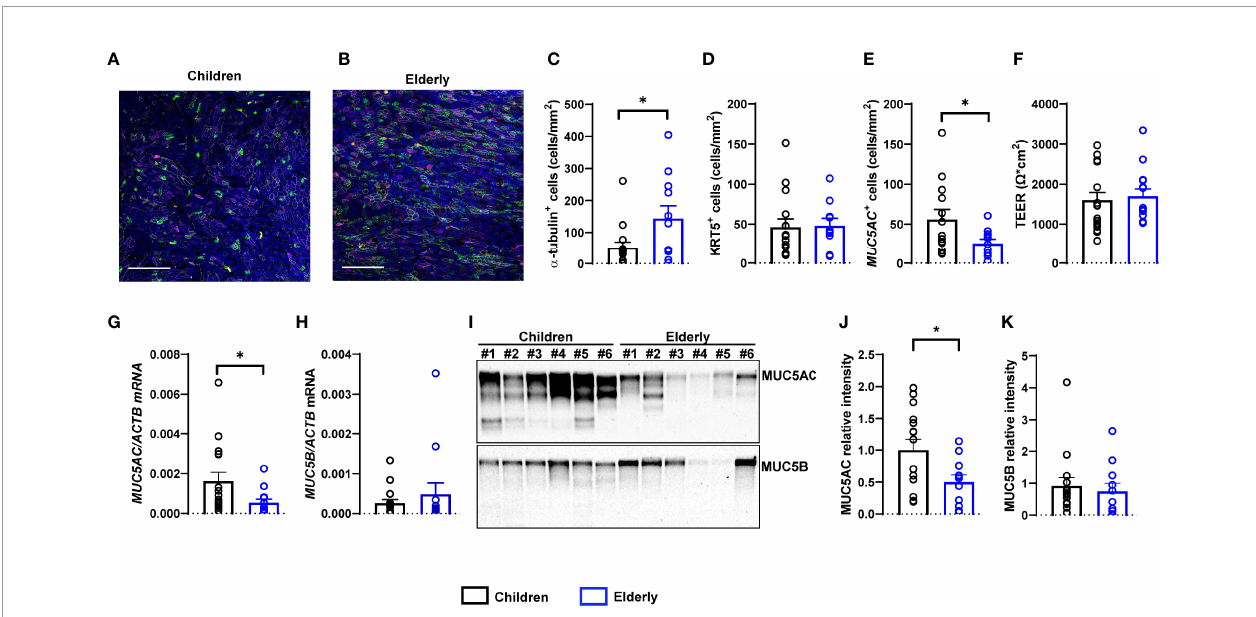
FIGURE 1 | Age-related differences in numeric densities of ciliated cells and MUC5AC expression in nasal epithelial cultures from children compared to elderly people. (A, B) Representative images of immuno fl uorescence of nasal epithelial cultures from healthy children and elderly people. Green: a -tubulin (ciliated cells), magenta: KRT5 (basal cells), yellow: MUC5AC (secretory cells), white: ZO-1 (tight junctions), and blue: Hoechst (cell nuclei). Scale bar, 100 µm. (C – E) Quanti fi cation of a -tubulin + (ciliated) cells (C) , KRT5 + (basal) cells (D) , and MUC5AC + (secretory) cells (E) ( n = 14 and 11 individuals per group). (F) Transepithelial electrical resistance (TEER) ( n = 17 and 14 individuals per group). (G, H) Transcript levels of MUC5AC (G) and MUC5B (H) ( n = 16 and 12 individuals per group). (I) Representative MUC5AC and MUC5B Western blot. (J, K) Protein quanti fi cation of MUC5AC (J) and MUC5B (K) by densitometry ( n = 15 and 11 individuals per group). * p < 0.05 compared to children. Data are shown as mean±S.E.M. Statistical analysis was performed with unpaired two-tailed t test in (D-F, J) , and with two-tailed Mann – Whitney test in (C, G, H, K)